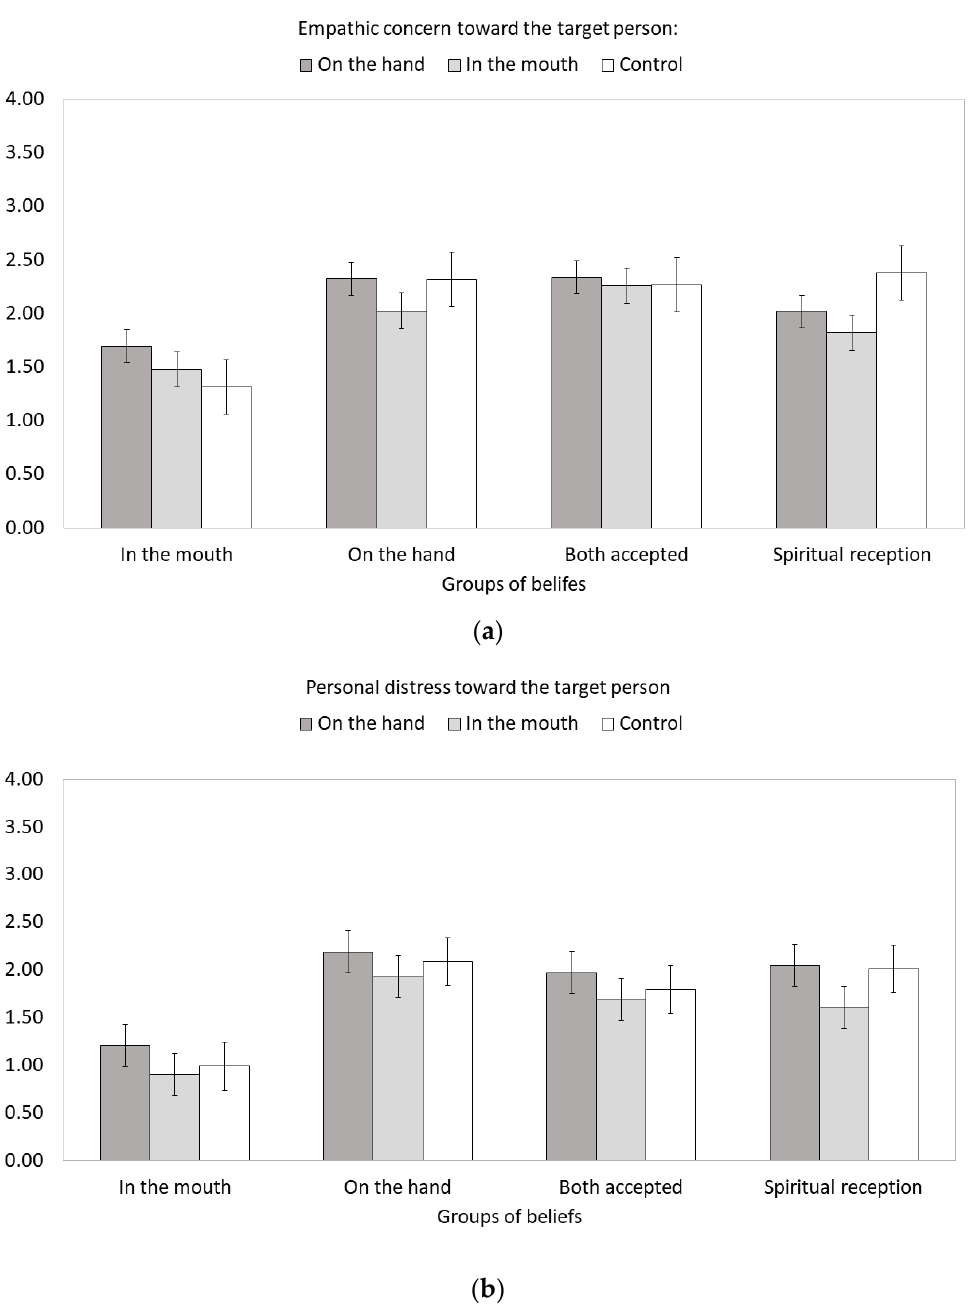
Figure 3. Empathic concern ( a ) and personal distress ( b ) reported toward target person by people sharing different beliefs about the proper form of reception of Holy Communion during the pandemic.